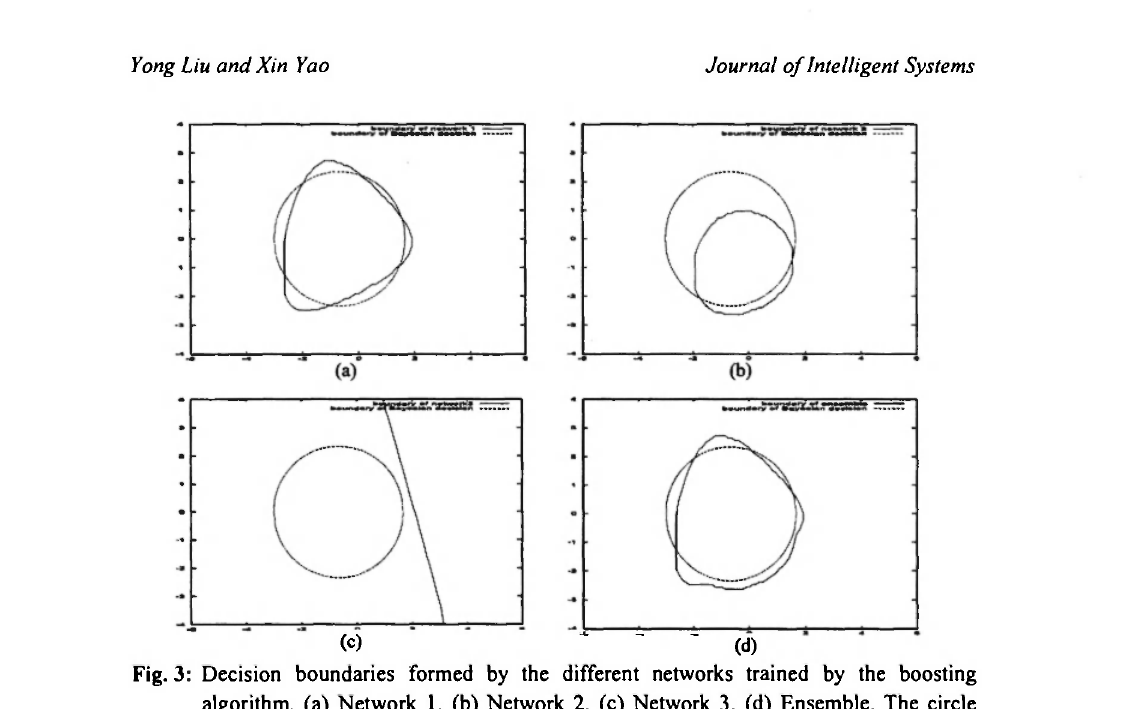
Fig. 3: Decision boundaries formed by the different networks trained by the boosting algorithm, (a) Network 1. (b) Network 2. (c) Network 3. (d) Ensemble. The circle represents the optimum Bayes solution.